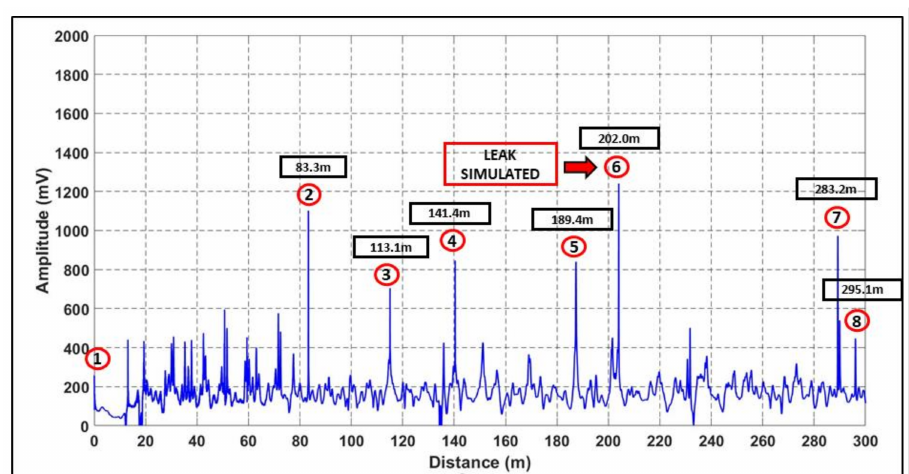
Figure 22. Hilbert Transform (HT) analysis IMF series 6 for 5 mm leak induced on fire hydrant 3.